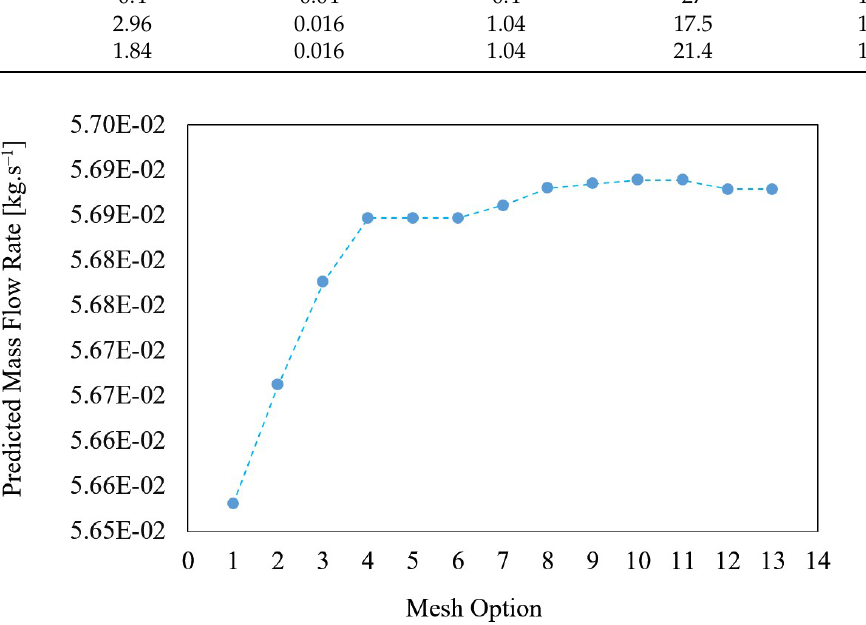
Figure 6. Estimated mass flow rate as a function of mesh option.